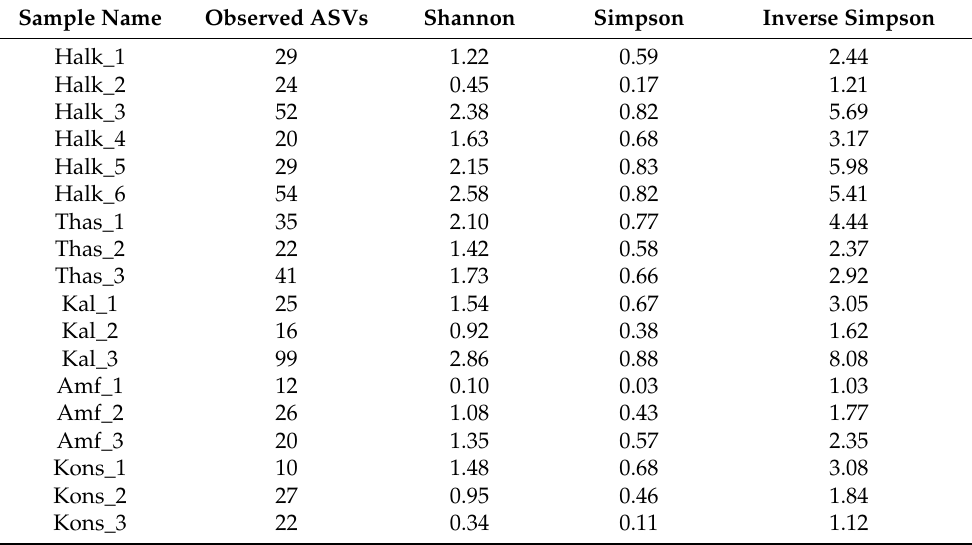
Table 3. Number of ASVs (amplicon sequence variants) and alpha diversity indices for each sample based on 18S rRNA amplicon